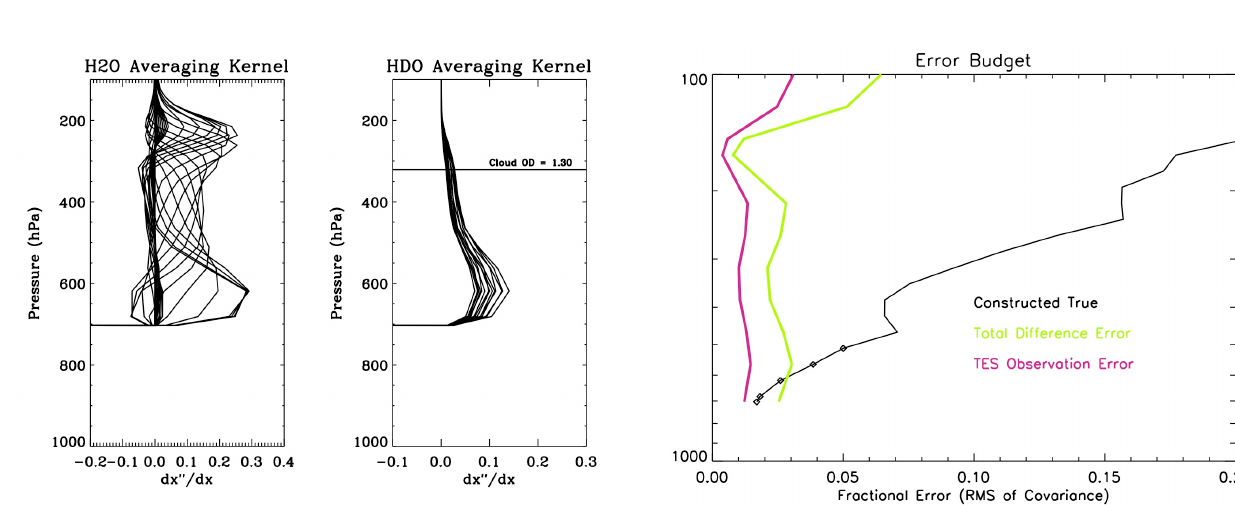
Fig. A10. Same as in Fig. A5 but for 5 November 2008. Figure A10: Same as in Figure A5 but for November 5 2008.